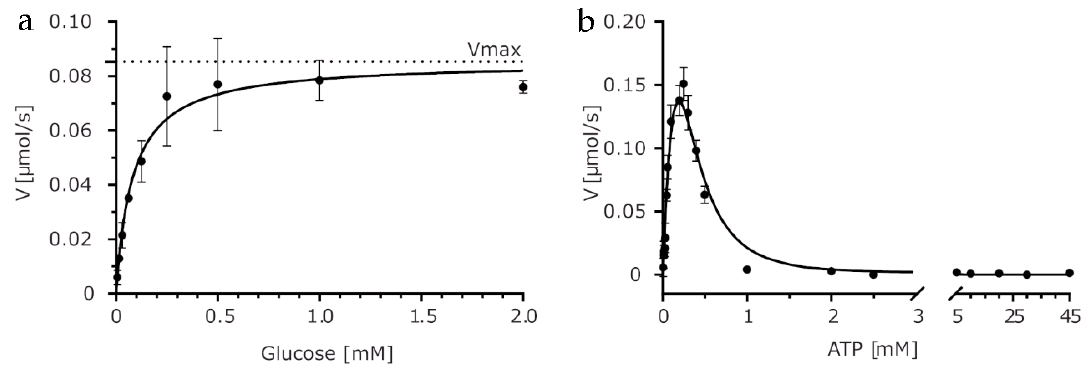
Figure 1. Kinetic analysis of Kl Glk1 activity. ( a ) Reaction velocity as a function of glucose concentration measured at 0.5 mM ATP. Solid line represents fit of standard Michaelis–Menten model, R 2 = 0.98; V max (0.085 ± 0.004 µ M / s; dotted line), k cat (app) (150 s − 1 ) K m (0.082 ± 0.013 mM). Error bars correspond to SD, N = 3. ( b ) Reaction velocity as a function of ATP concentration measured at 0.5 mM glucose. Substrate inhibition is clearly visible starting from 0.25 mM ATP. Solid line indicates a substrate inhibition model with a correction for dimerization, R 2 = 0.97. Error bars correspond to SD, N = 3.